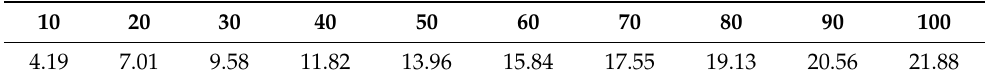
Table 7. Values of Uniformity at different MLEM iterations. All values are in % .